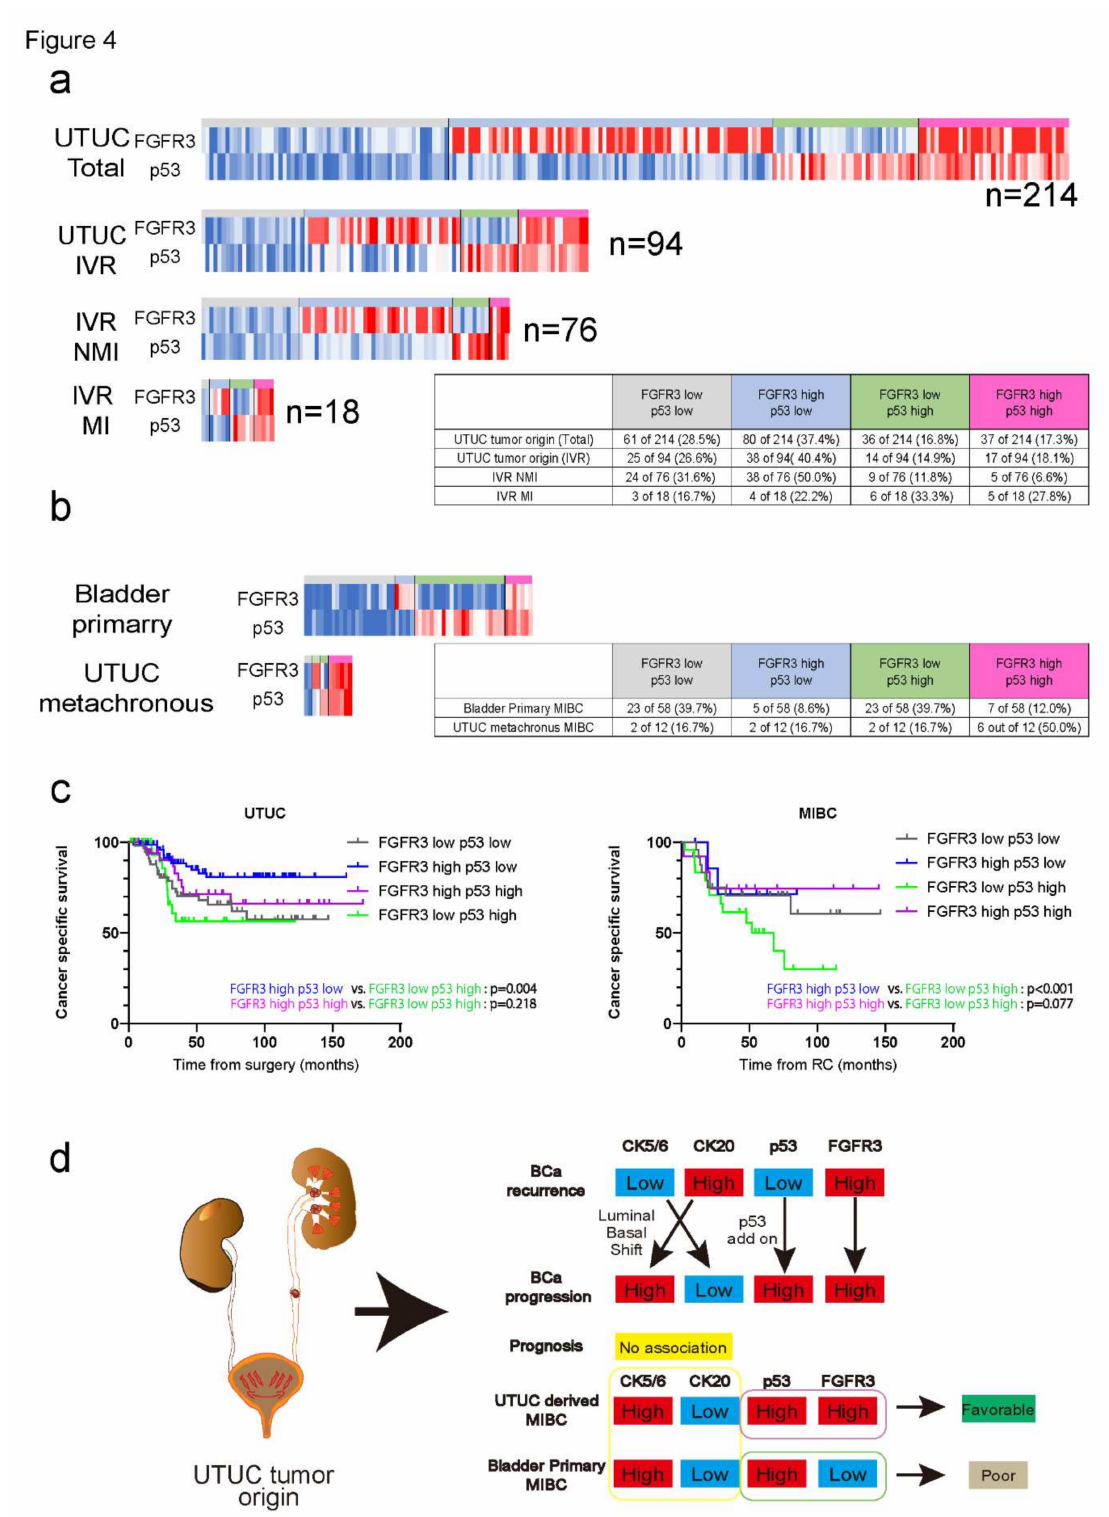
Figure 4. ( a ) Heatmap describing the relationships of FGFR3 and p53 expressions from UTUC tumor origin to MIBC progression. Gray bar shows both FGFR3 and p53 low group. Light blue bar shows FGFR3 high but p53 low group. Yellow-green bar shows FGFR3 low but p53 high group. Purple